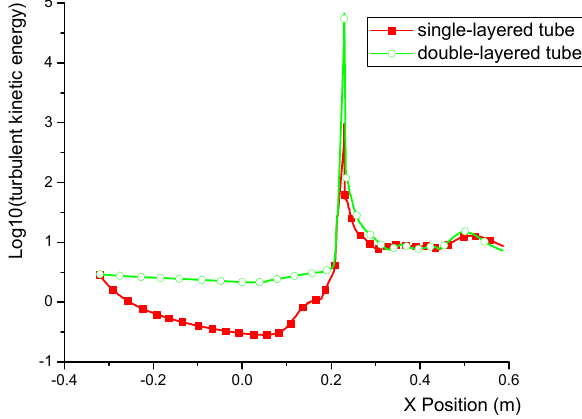
Figure 9. The turbulent kinetic energy distribution.